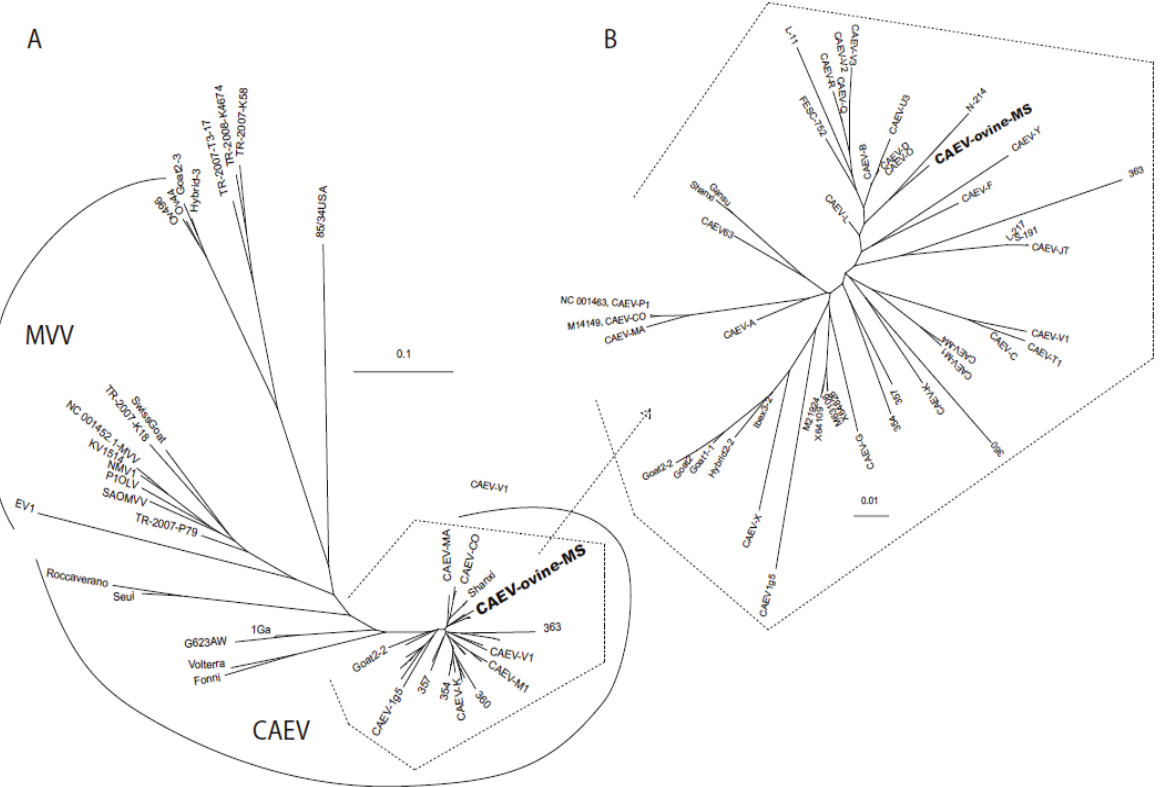
Figure 4. Phylogenetic dendrogram comparing the nucleotide sequences of the CAEV U3 isolates and relationship to other GenBank sequences. ( A ) Phylogram of representative caprine-arthritis-encephalitis viruses (CAEV) and maedi-visna viruses (MVV) GenBank sequences. ( B ) Phylogram of the CAEV sequences enclosed in an open polyhedron in ( A ). CAEV-ovine-MS is depicted in bold type. The scale bar in both ( A ) and ( B ) indicates the number of substitutions per site. Select GenBank accession numbers of sequences included are shown in the text. The GenBank numbers for the sequences used in this dendrogram are in Supplementary Table